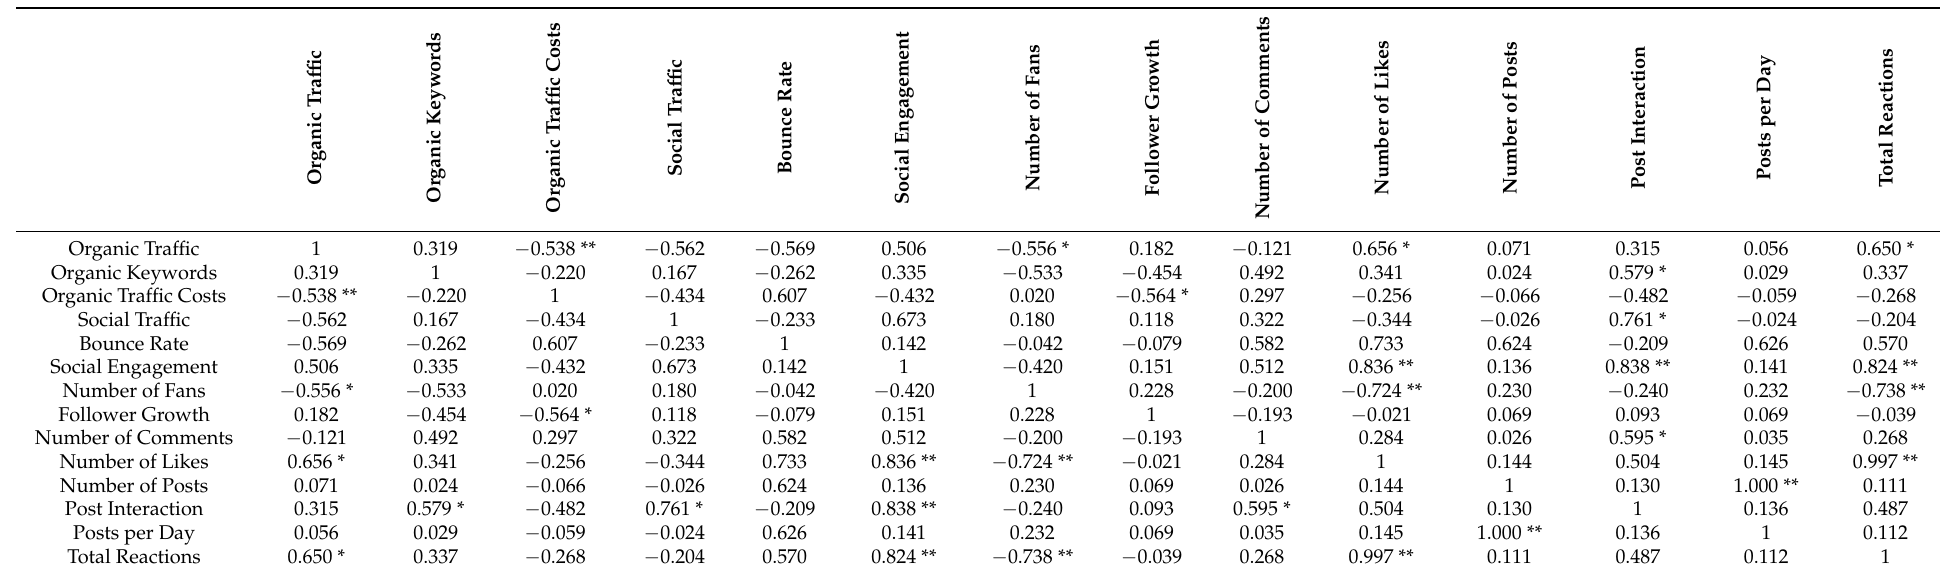
Table 1. Correlation Analysis